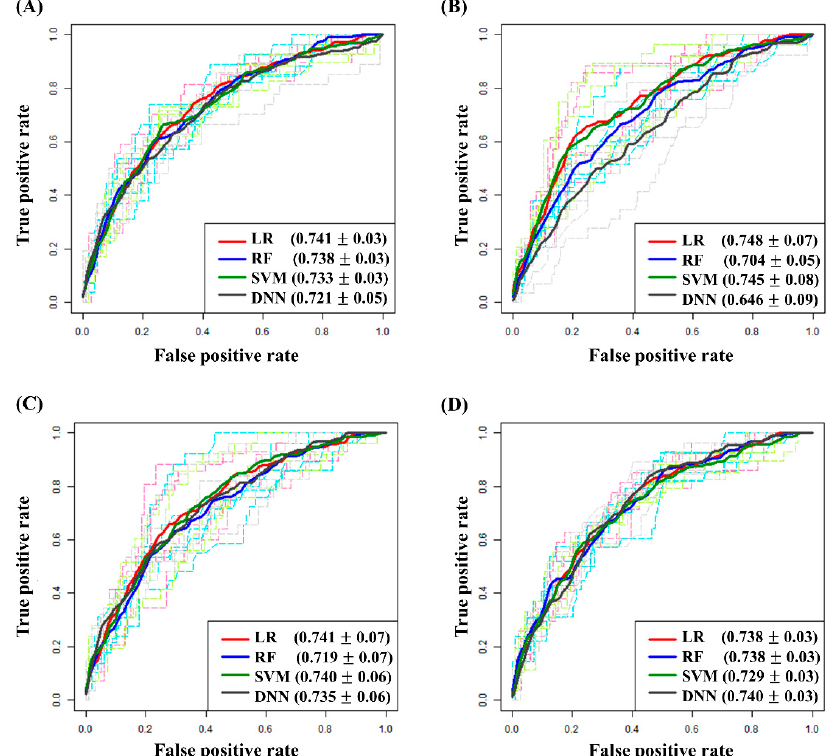
Figure 3. ROC curves for comparative models obtained via five-fold cross-validation. ( A ) Models consisting of six selected variables; ( B ) Models consisting of six selected variables and FIGO stage; ( C ) Mod- els consisting of six selected variables and residual tumor size after debulking surgery; ( D ) Models consisting of six selected variables, FIGO stage, and residual tumor size after debulking surgery.